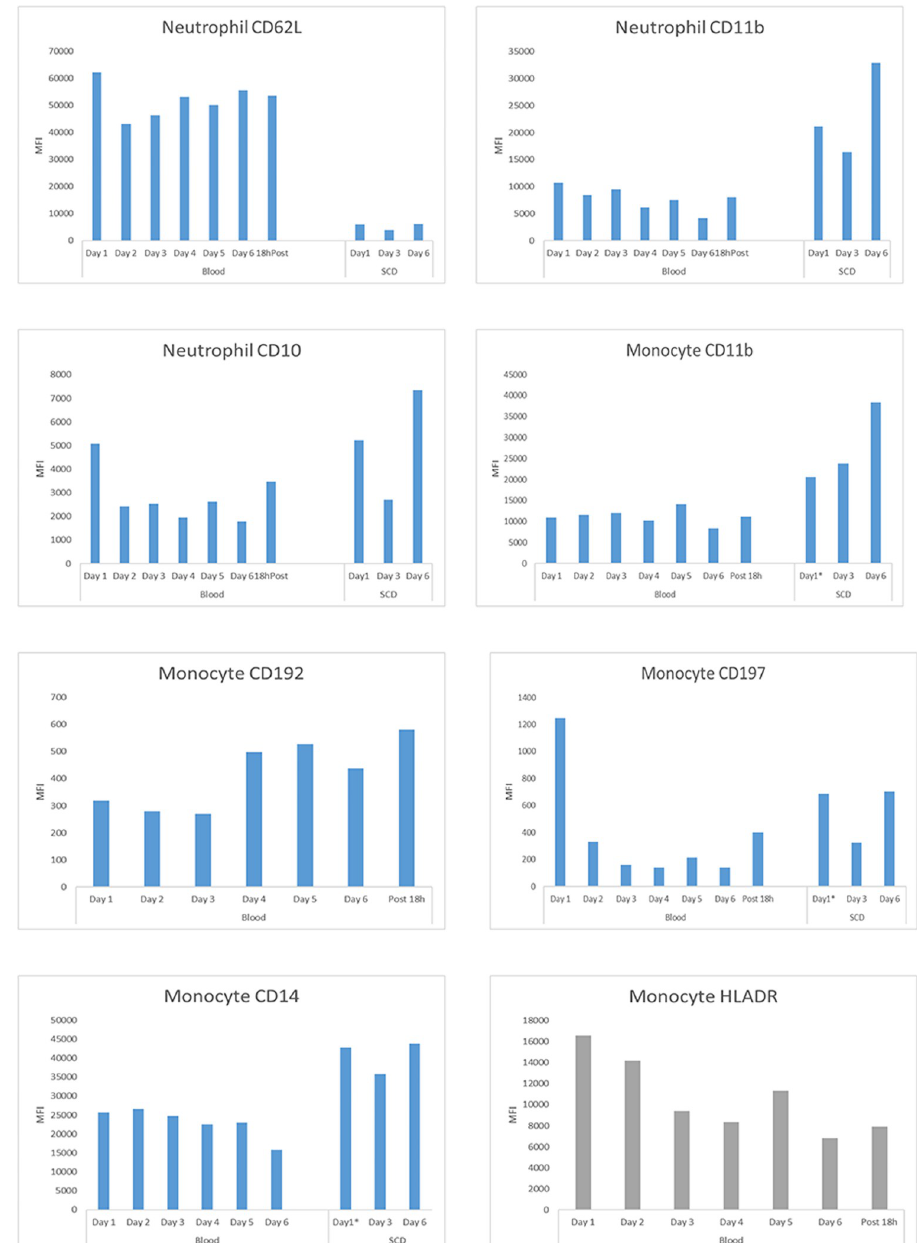
Fig 6. Effect of SCD treatment on leukocyte phenotypes in a patient with severe systolic HF. Each graph displays the MFI of various cell surface markers on either circulating blood neutrophils or monocytes during the 6 day course of daily 6 hours of SCD treatment. Also displayed are the MFIs of the eluted neutrophils and monocytes from the SCD after treatments on day 1, 3, and 5. All monocyte graphs depict the MFI of the entire monocyte population except for the Monocyte HLADR graph which presents the MFI of the surface marker of HLADR in the intermediate (CD14 +CD16+) monocyte subpopulation. Day 1 values were baseline measurements prior to initiation of SCD treatment. Day 2 and all subsequent Days represent values obtained during the morning after the prior day’s